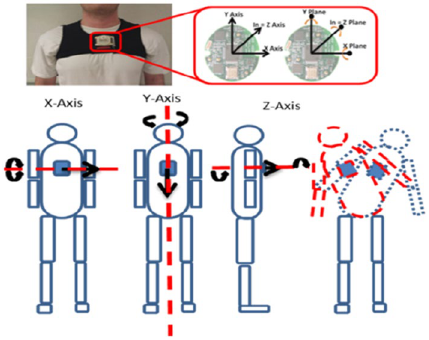
Figure 5. Placement of a wearable IMU